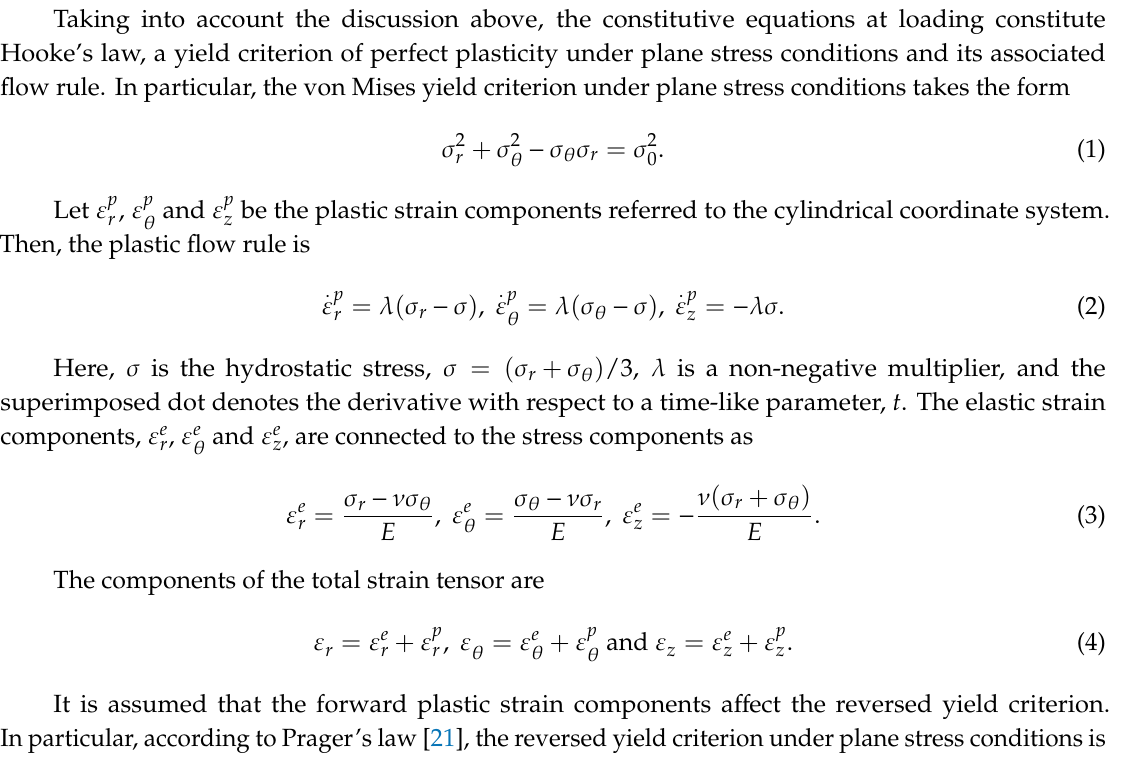
Figure 2. Geometric illustration of the Bauschinger effect considered in the present paper.